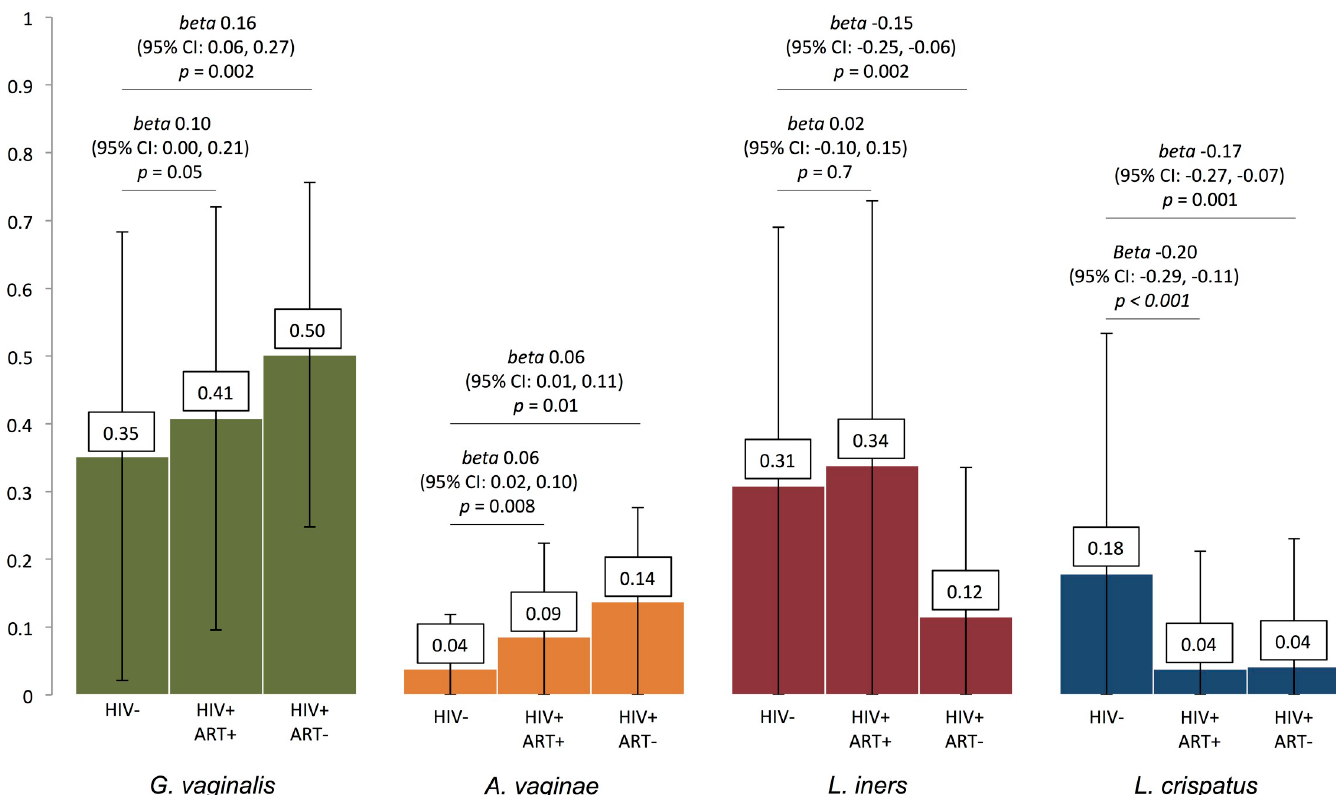
Fig 2. Differences in relative abundance of 4 key bacterial taxa by HIV serostatus and ART timing. Relative proportions with regression coefficients and 95% confidence intervals of Gardnerella vaginalis , Atopobium vaginae , Lactobacillus iners , and Lactobacillus crispatus among HIV-infected women with (ART+) and without (ART-) preconceptional exposure to antiretroviral therapy compared to HIV-uninfected women. HIV-infected women with and without preconceptional ART exposure demonstrate higher abundance of Atopobium vaginae and lower Lactobacillus crispatus , whereas those without preconceptional ART exposure have higher Gardnerella vaginalis abundance and lower Lactobacillus crispatus . All regression coefficients adjusted for maternal age, body mass index, and parity. ART, antiretroviral